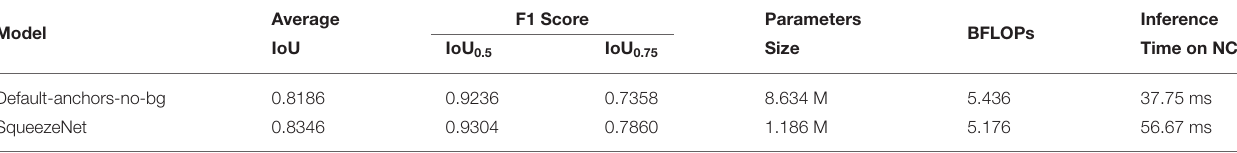
TABLE 5 | Performance data of SqueezeNet.